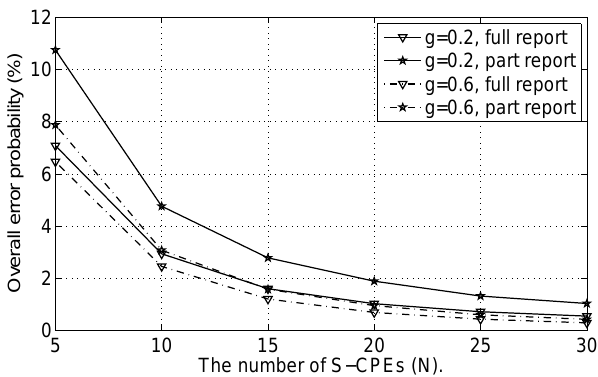
Figure 9. Fused overall error probability at a R-CPE as function of the number of S-CPEs. Rayleigh fading channel with ¯ γ of 10 dB, γ =5 dB. T